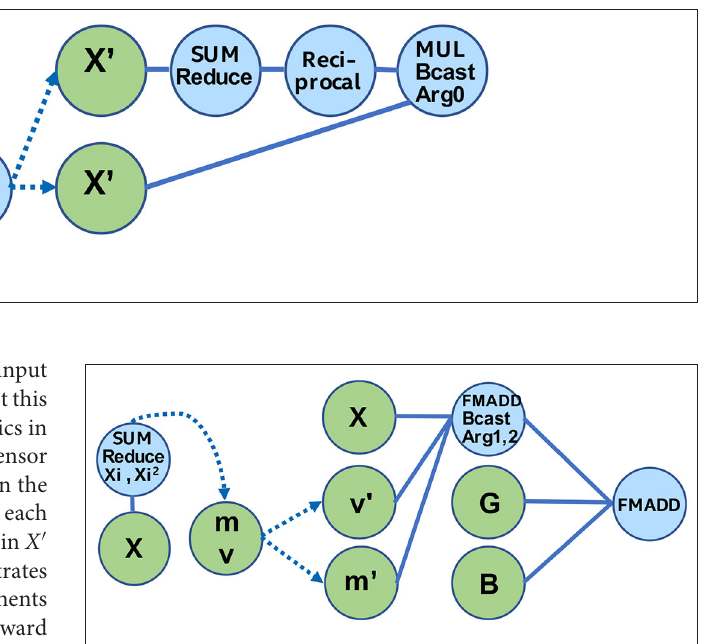
FIGURE 15 | Layernorm via